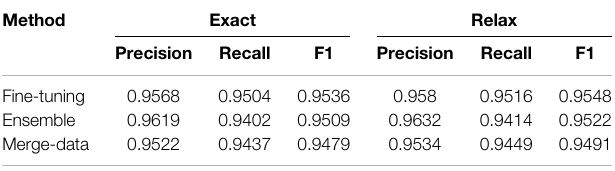
TABLE2| Performancesofeventextractionforchemicalreaction.Bothexactand relaxed matching results are reported.